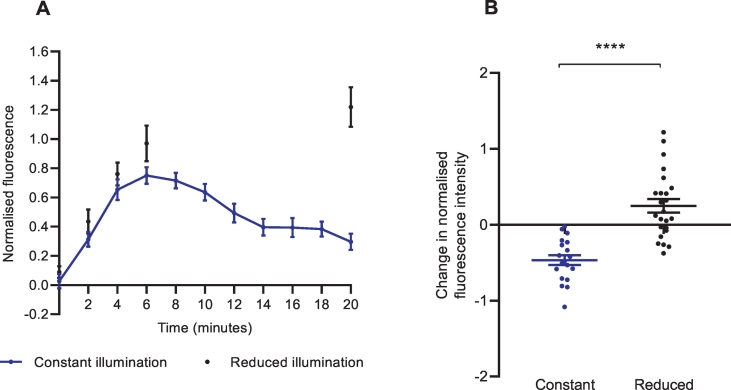
Frequent imaging protocols resulted in an attenuation of NTUA-induced fluorescence intensity in nerve terminals of the mouse left atrial appendage.(A) Timeline of NTUA-induced fluorescence in different imaging conditions. Constant imaging conditions (2-minute intervals for 20 min) resulted in an attenuation of normalised fluorescence intensity between t = 6 and t = 20 (n = 4, nt = 19); the opposite was true when an absence of imaging occurred at t = 8–18 (n = 4, nt = 24).(B) The change of normalised fluorescence intensity between t = 6 and t = 20 in different imaging conditions. The constant imaging conditions tended towards a negative change in normalised fluorescence intensity whereas there a positive change for the reduced imaging conditions. Constant (n = 4, nt = 19) vs. reduced (n = 4, nt = 24), unpaired Student's t-test.Data presented as mean ± SEM. **** denotes p < 0.0001.